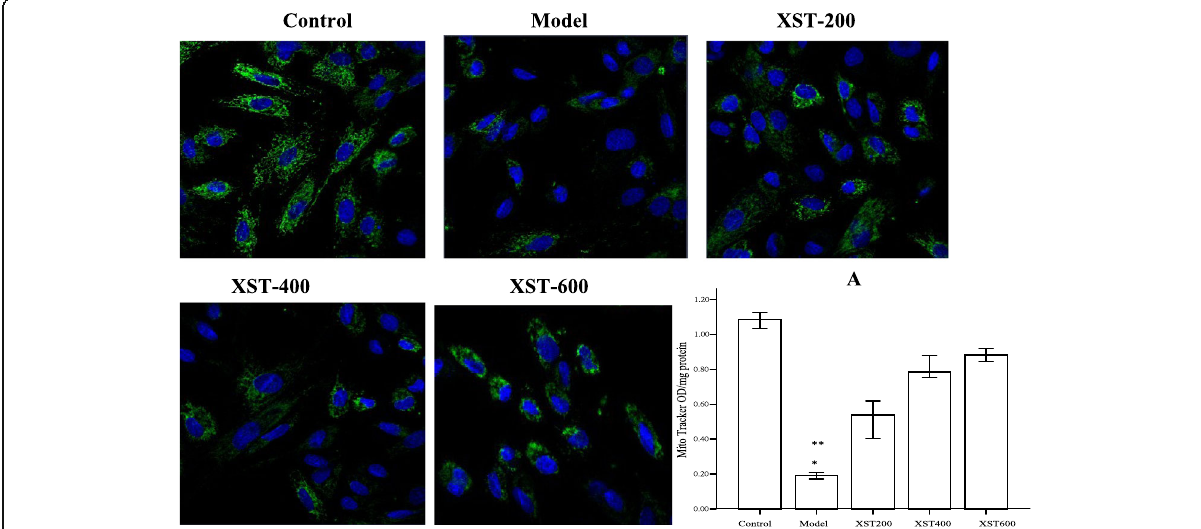
Fig. 4 Mitochondrial content (using MitoTracker Green) was detected in the five groups, showing the green fluorescence increased in a XST dose dependent manner. Quantitative assessment showed that XST-treated groups were significantly greater than that in the control (bar graphs ( a ). All samples were checked in three independent experiments with three replicates each. Data are represented as the mean ± SD ( * P <0.05 vs. XST 400 and 600 μ g/ml, ** P <0.001 vs. the control group)